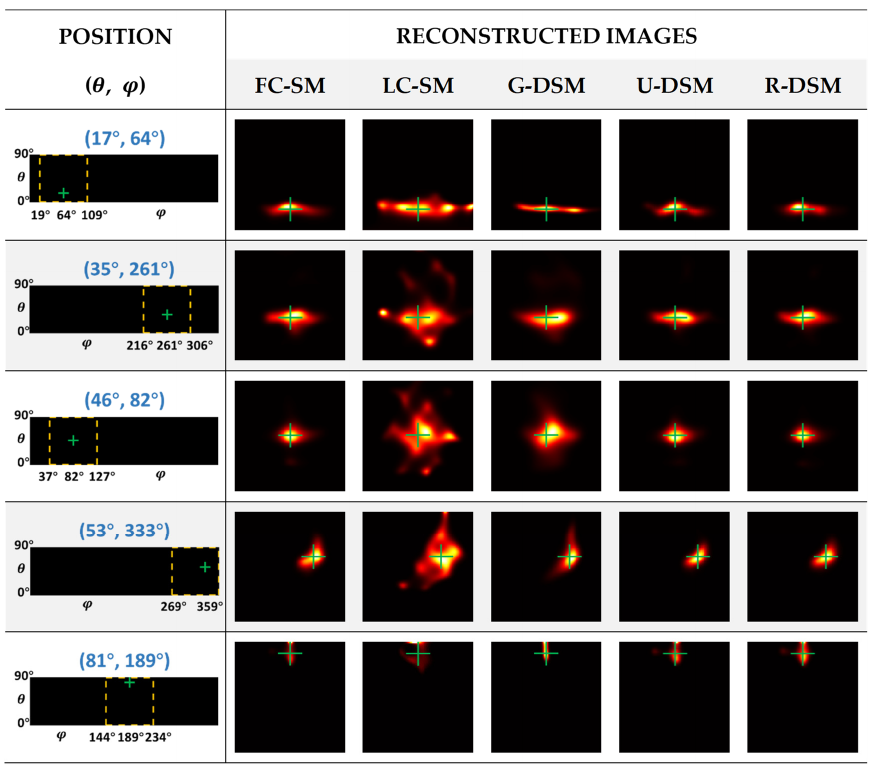
Figure 13. Reconstructed images of different SMs at representative positions for 137 Cs source in intra-device evaluation.